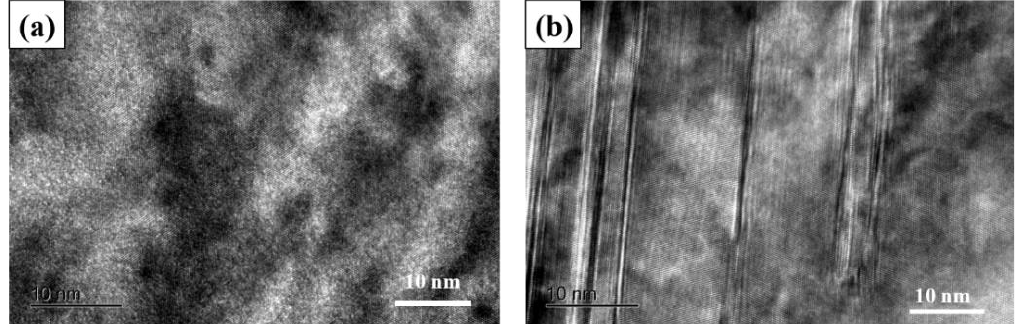
Figure 11. TEM micromorphology of high-entropy alloy coatings. ( a ) CS coating; ( b ) HVOF